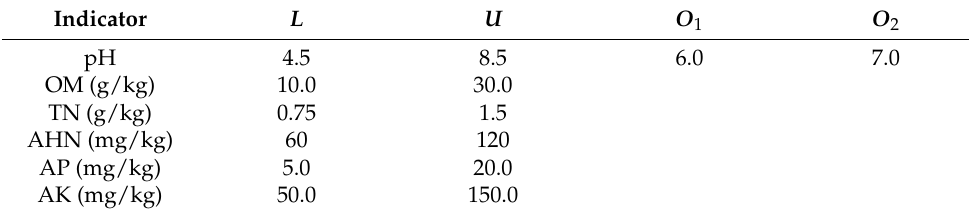
Table 2. Thresholds for the membership function of soil fertility indicators.